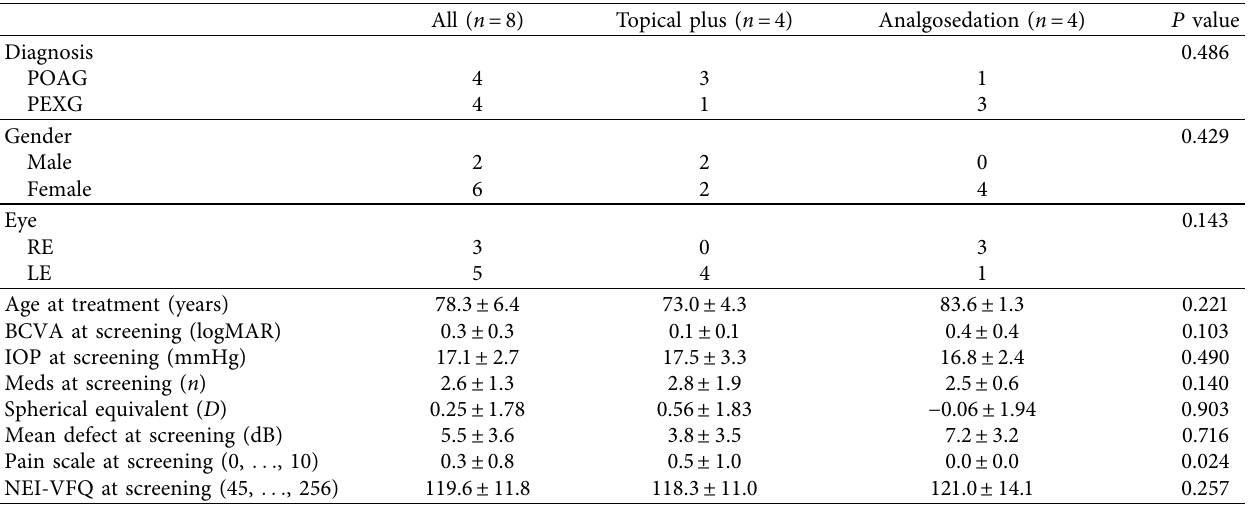
Table 1: Demographics.